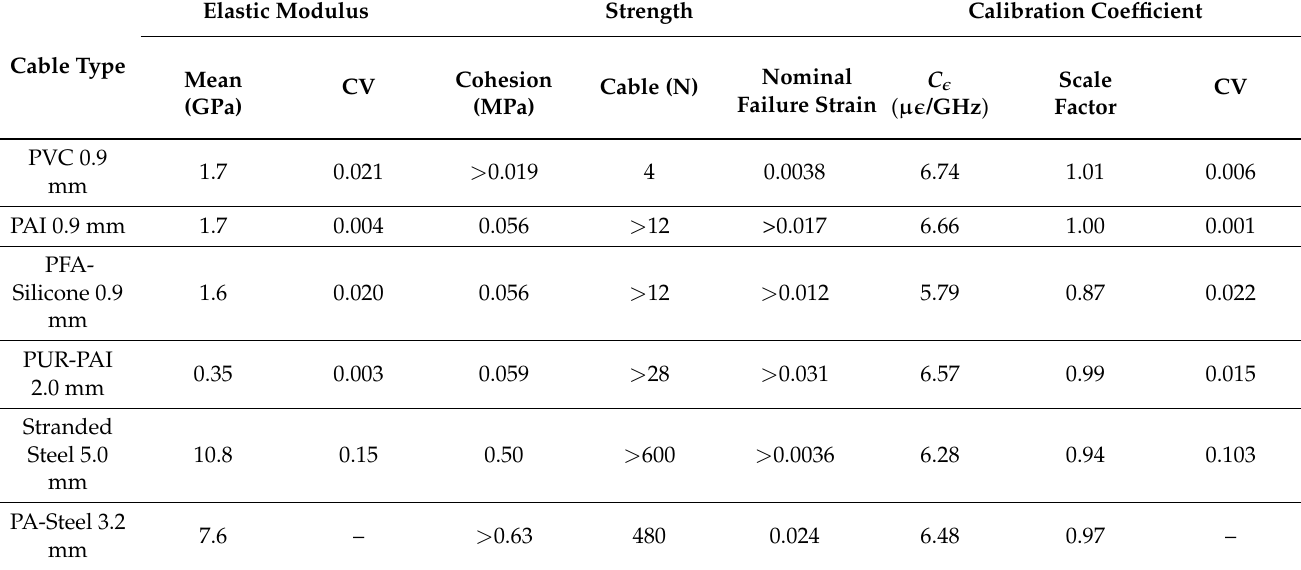
Table 1. Mechanical parameters and calibration